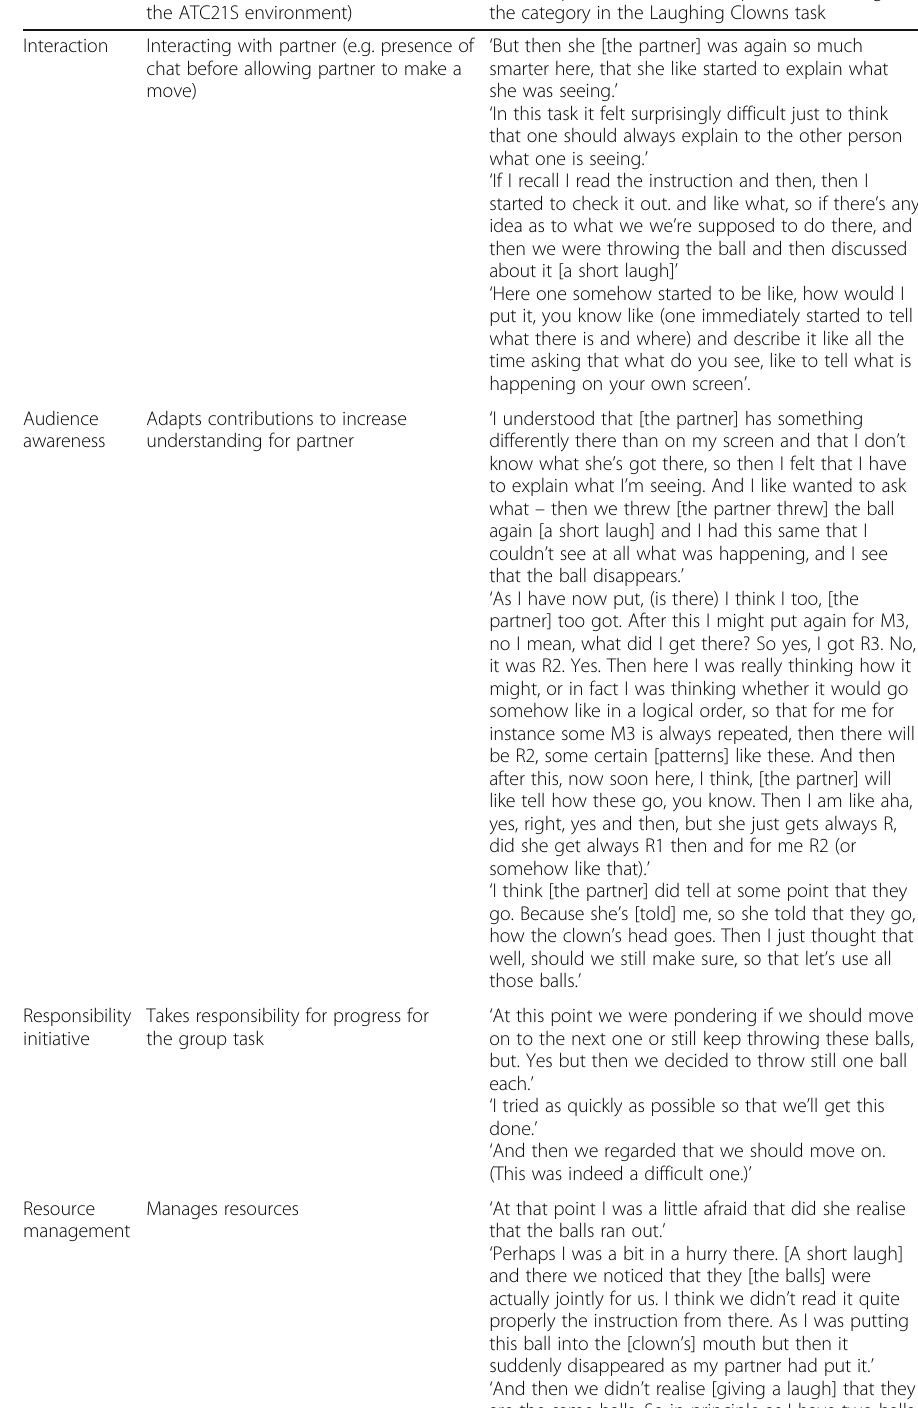
Table 9 Examples of the coded primary data from the cued retrospective reporting (CRR) data (from the Laughing Clowns